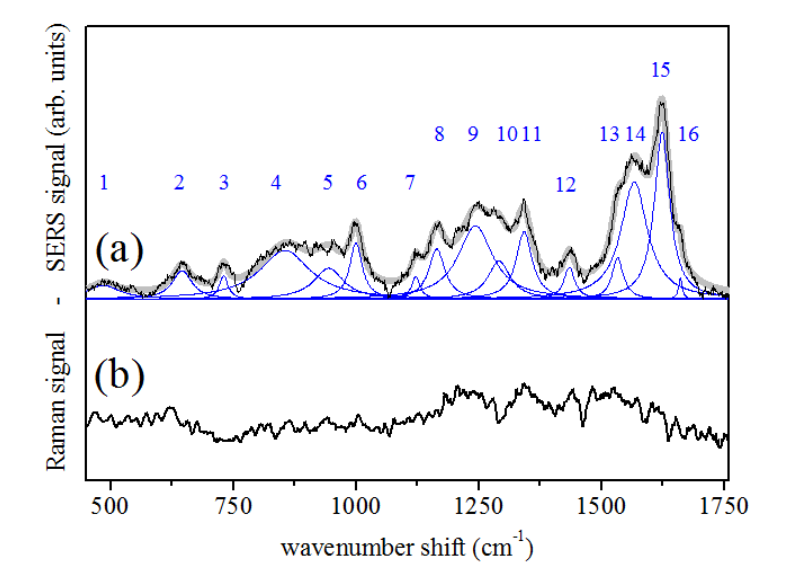
Figure 3. ( a ) SERS spectrum of human tears. The experimental data were fitted by a convolution of Lorentzian functions (numbered blue peaks) representing the main Raman modes occurring in the sample (see Table 2 for a temptative assignment of the Raman modes. ( b ) Conventional Raman spectrum of dried human tears (the signal in ( a , b ) are arbitrary scaled).